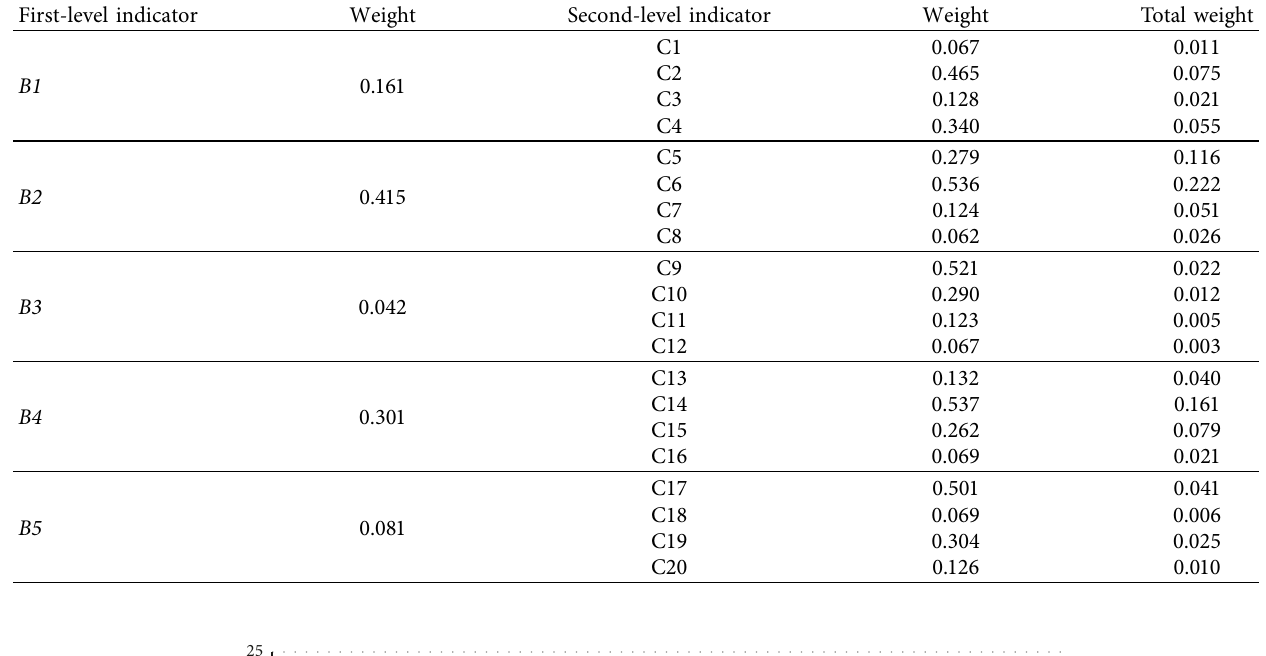
Table 9: Performance evaluation indicator weight of IEE.